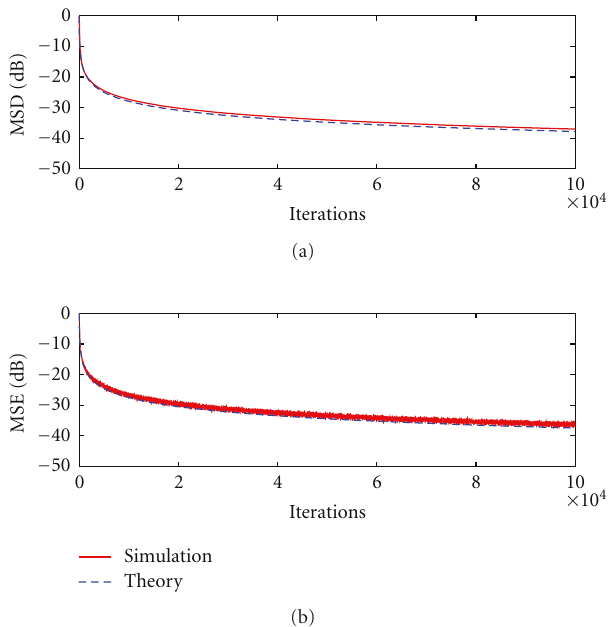
Figure 7: Theoretical and simulated MSD (a) and MSE (b) learning curves of the SRLMF algorithm using Gaussian regressors with an eigenvalue spread = 5, SNR = 50